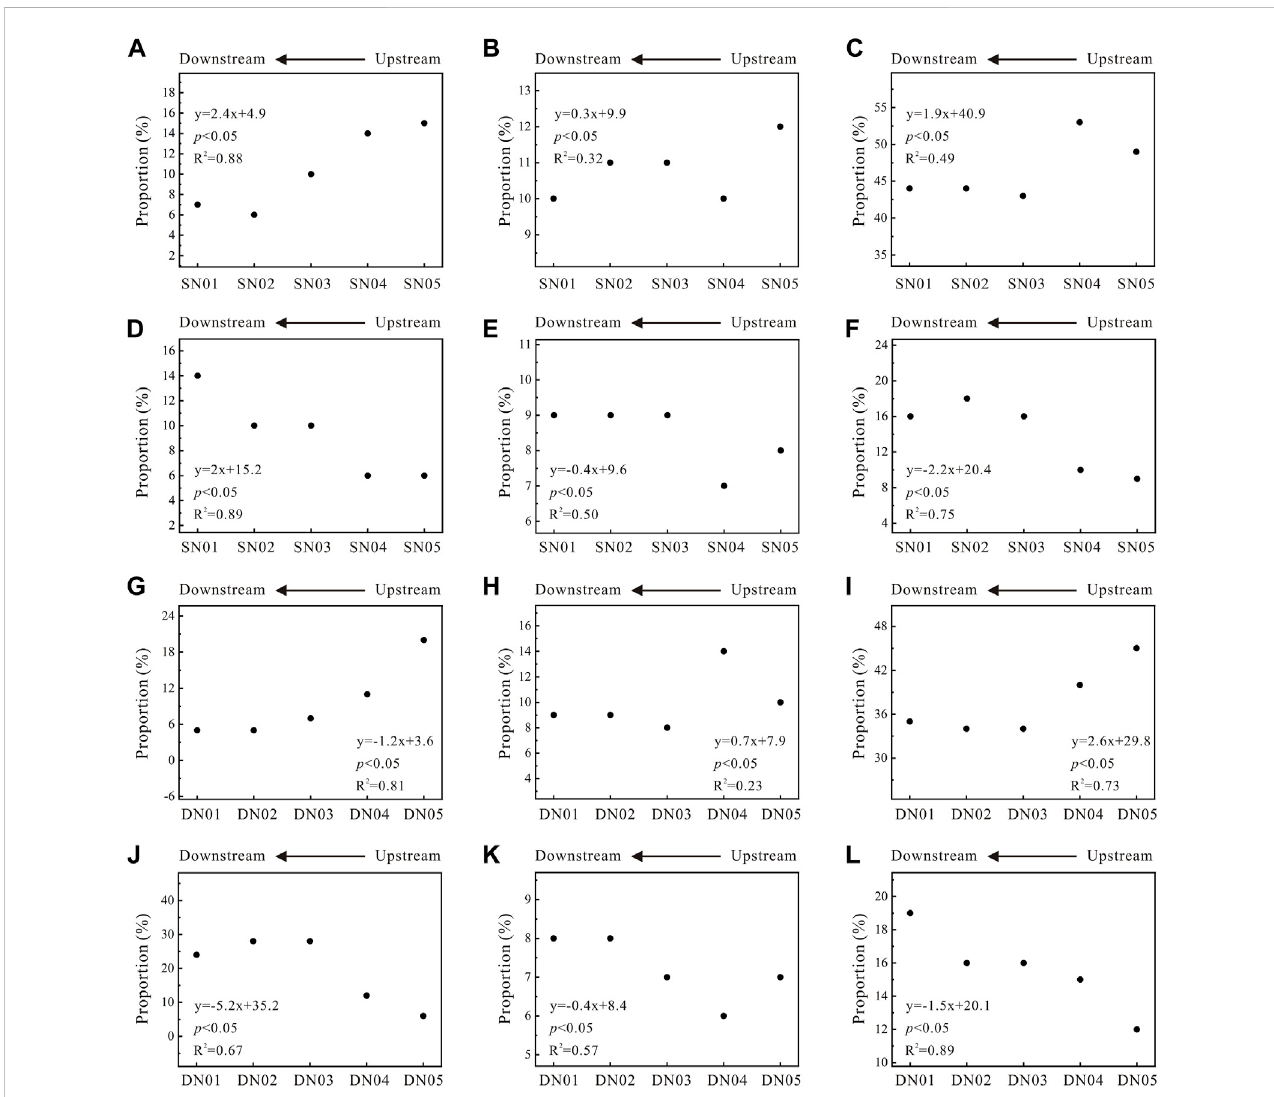
FIGURE 2 Mineral composition of sediments in SNR and DNR: (A) dolomite, (B) feldspar, (C) quartz, (D) calcite, (E) chlorite, and (F) illite in SNR; (G) dolomite, (H) feldspar, (I) quartz, (J) calcite, (K) chlorite, and (L) illite in DNR.